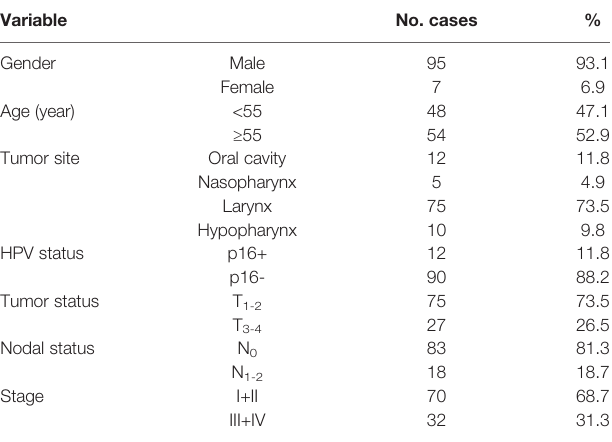
TABLE 1 | Clinicopathological characteristics of